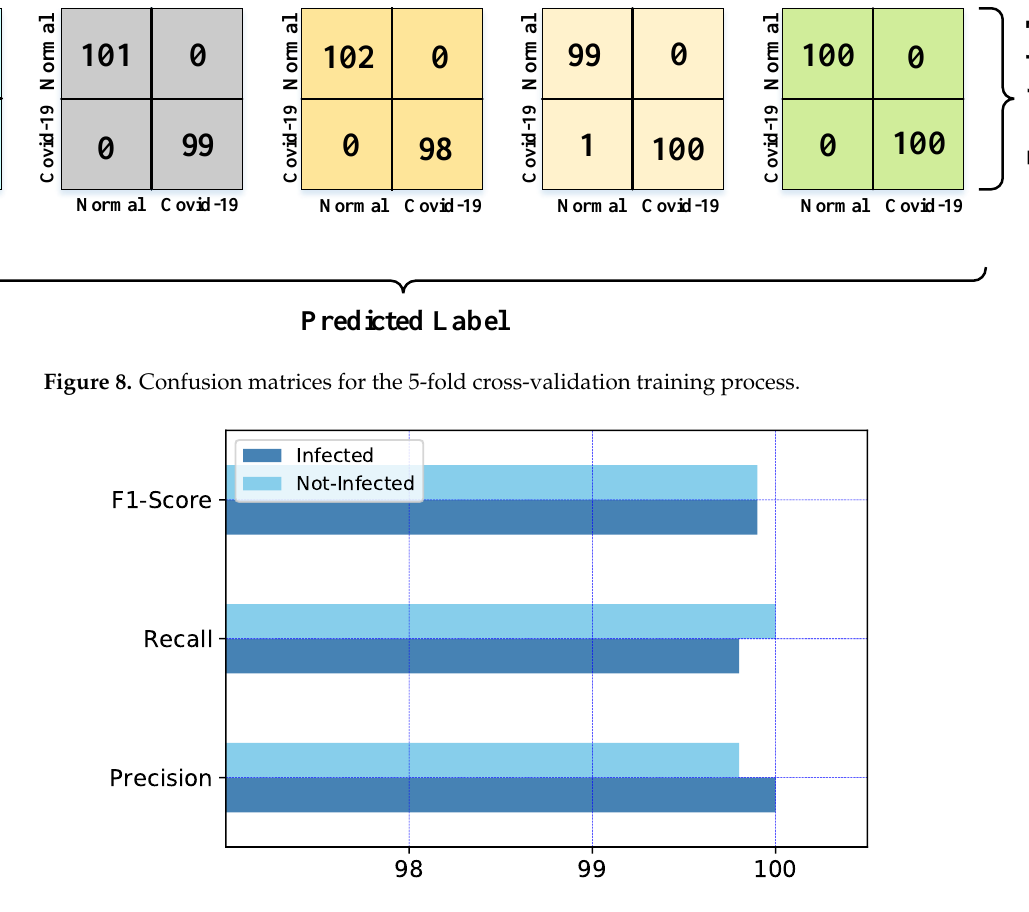
Figure 9. The graph of model performance in average of 5-fold cross-validation for both classes.